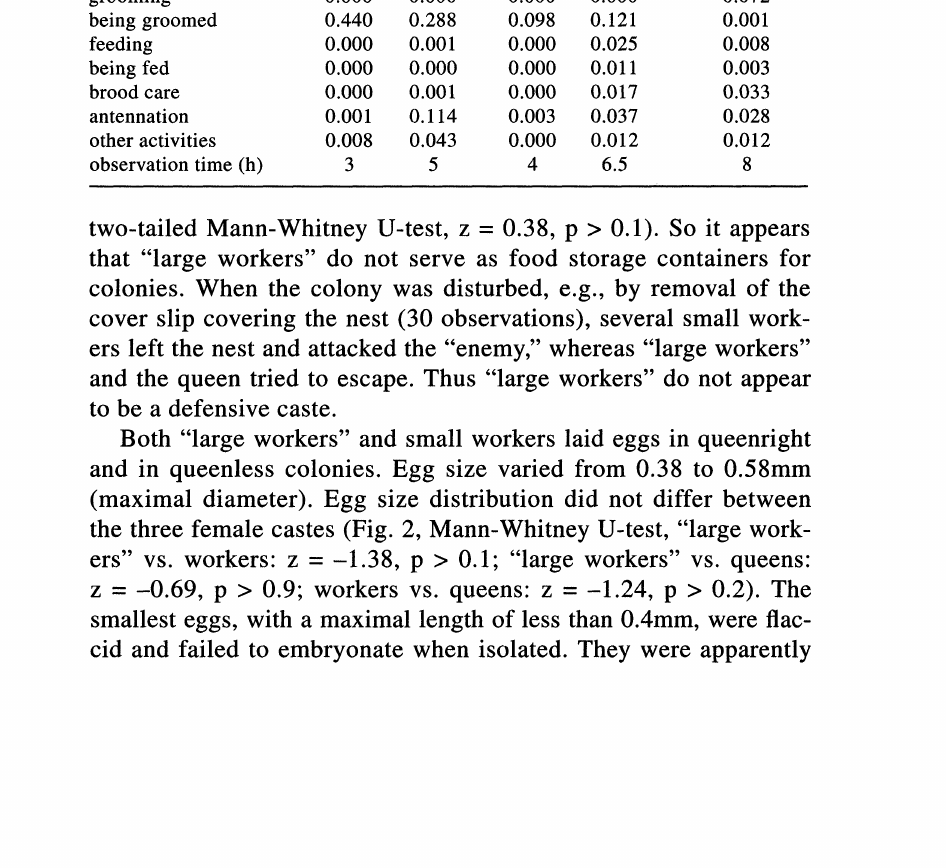
Table 2. Approximate time budget of the three female castes in the ant Cre- matogaster smithi. Queens and "large workers" of two colonies were observed in individual observation sessions of ten minutes each, during which the exact dura- tion of all acts was recorded. The behavior of small workers was similarly ana- lyzed, however, the focus animal differed between individual observation sessions to cover the behavioral repertoire of as many workers as possible. A video-analysis of approximately 100 additional hours, during which the behavioral status of indi- viduals was recorded in irregular time intervals, supports the data from the time budget study. The category "feeding" includes both the offering of food (in "large workers" and queens, see text for details) and actual trophallaxis (in small work- ers). "Other activities" include cleaning the nest, feeding on honey or eggs, food begging, defecation, and egg laying. Several workers repeatedly bit the gaster tip of queen 2, which contributes to its high score in "other activities." During the total observation period, only queen 2 laid one